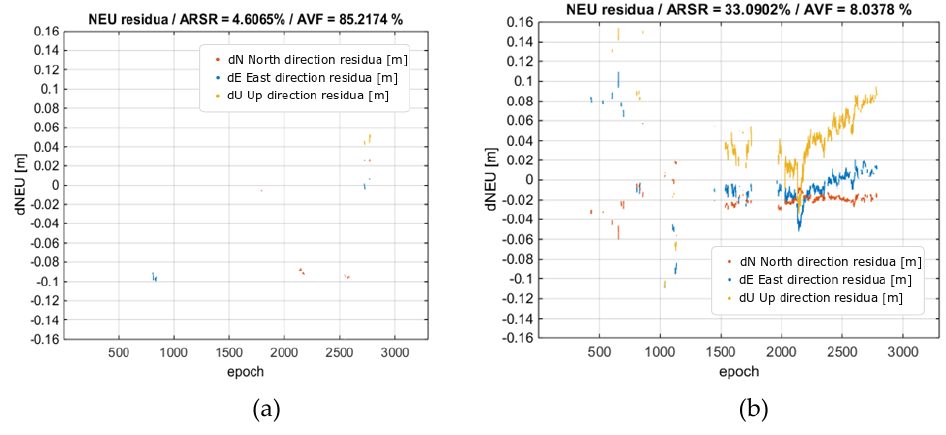
Figure 12. Rover position residua vs. the reference position from processing BROD baseline. ( a ) No ionospheric corrections; ( b ) With ionospheric corrections. Horizontal residuals are in red and blue, and height residuals are in yellow.